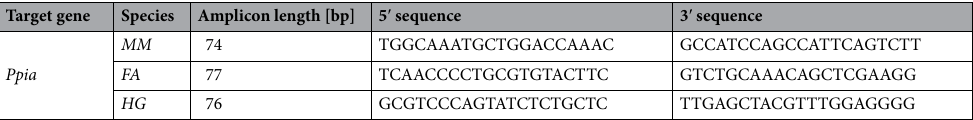
Table 1. List of primers used in the present study. MM: Mus musculus ; FA: Fukomys anselli ; HG: Heterocephalus glaber.